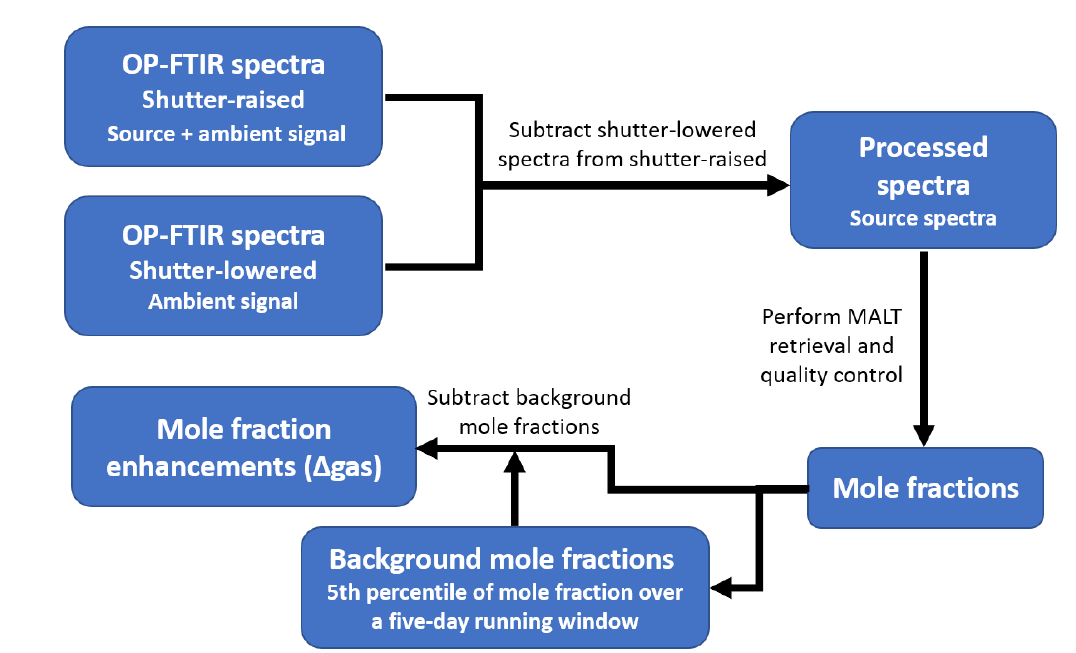
Figure 2. Workflow for the data processing performed in this study.